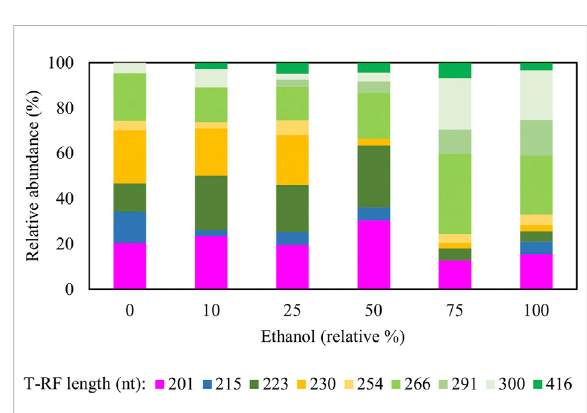
FIGURE 7 Terminal restriction enzyme fragment length polymorphism (T-RFLP) analysis (HaeIII digests) of ampli fi ed 16S rRNA genes of planktonic bacterial communities in the sul fi dogenic bioreactor fed with different combinations of ethanol and glycerol. Shades of blue represent known sulfate-reducing Firmicutes (215 nt, D. acididurans ), shades of yellow represent non- sul fi dogens (230 nt, Actinobacterium AR3; 253 nt, At. ferrooxidans ),shadesofgreenrepresentbacterialclonesidenti fi ed as probable non-sul fi dogens and the magenta bars represent clone SRB7 (201 nt; Dv. desulfuricans